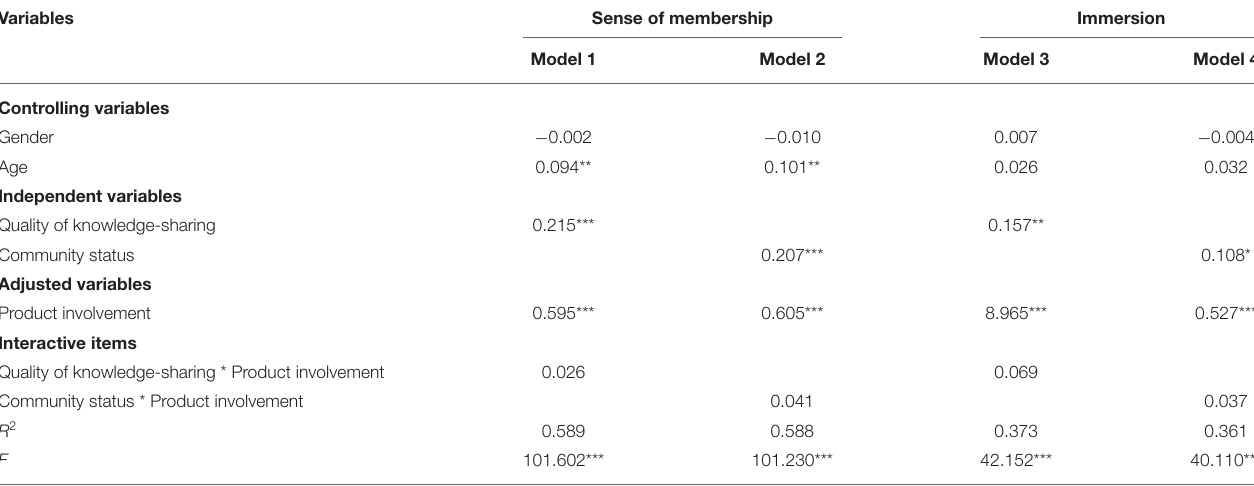
TABLE 7 | Results of multilevel regression analysis of